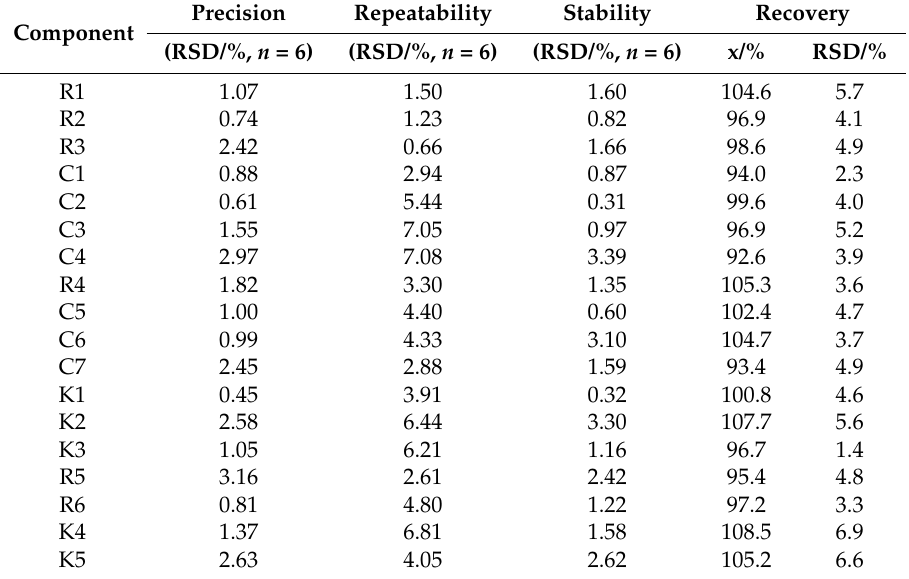
Table 2. Precision, repeatability, stability and recovery test results of the HPLC